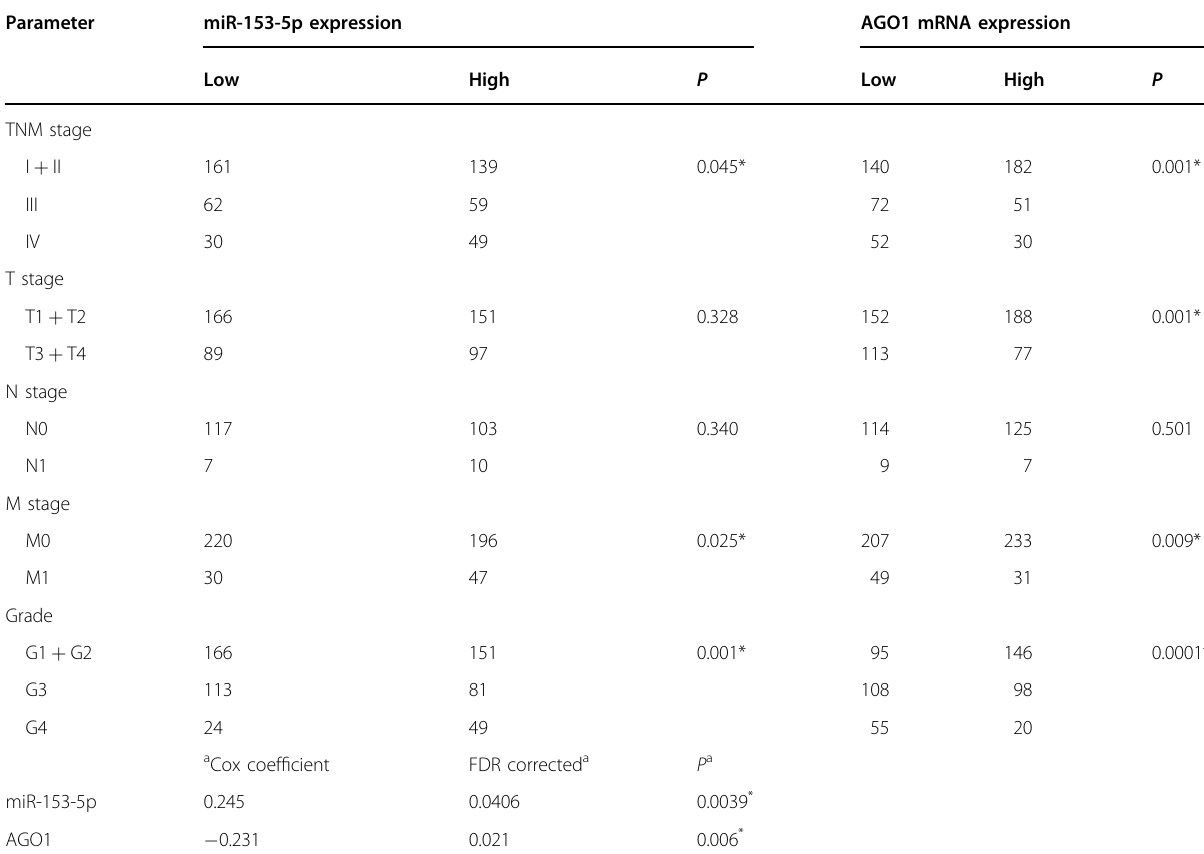
Table 1 Correlations of miR-153-5p and AGO1 mRNA with clinicopathological characteristics in patients with ccRCC.